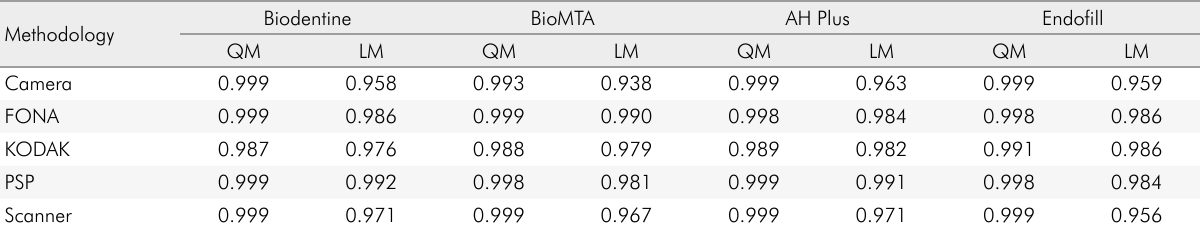
Table 2. Coefficients of determination (R 2 ) values of quadratic and linear models for all radiographic methodologies and endodontic